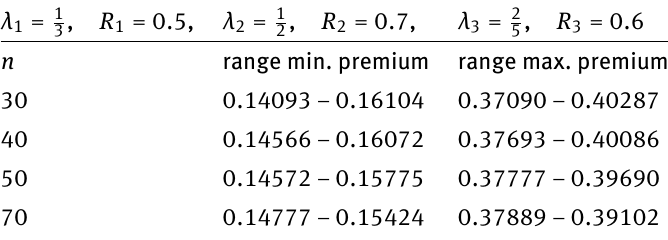
Table 3: Upper and lower bounds for the minimal and the maximal premium. The interest rate was set to r = 0.05 . , R 1 = 0.5 , λ 2 = 1 , R 2 = 0.7 λ 1 = 1 3 2